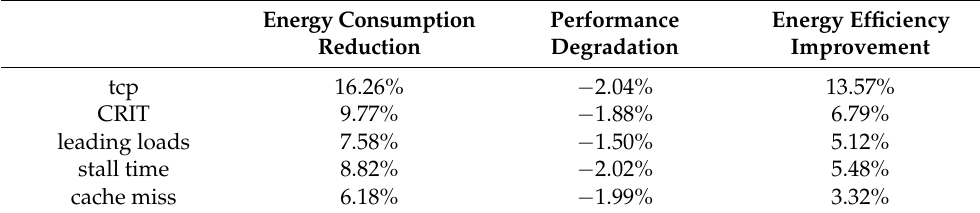
Table 4. Comparison of results of different power management strategies.